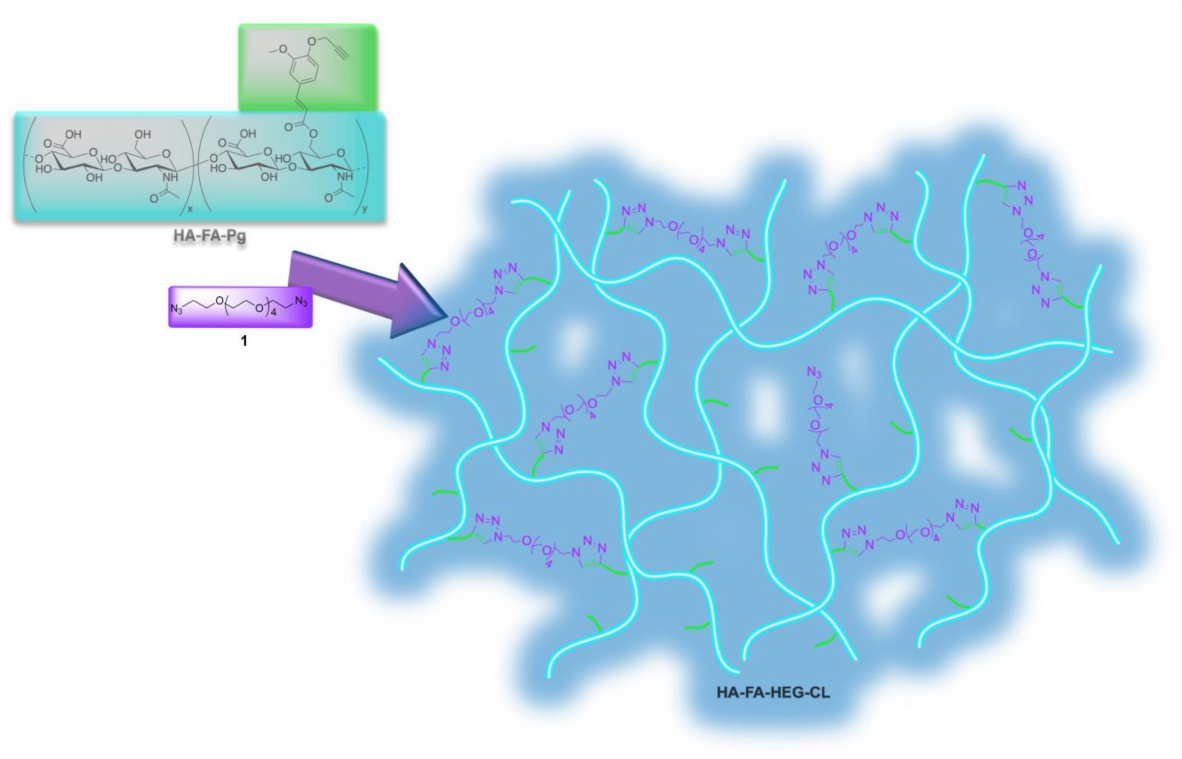
Figure 2. Click-chemistry cross-linking of HA-FA-Pg graft